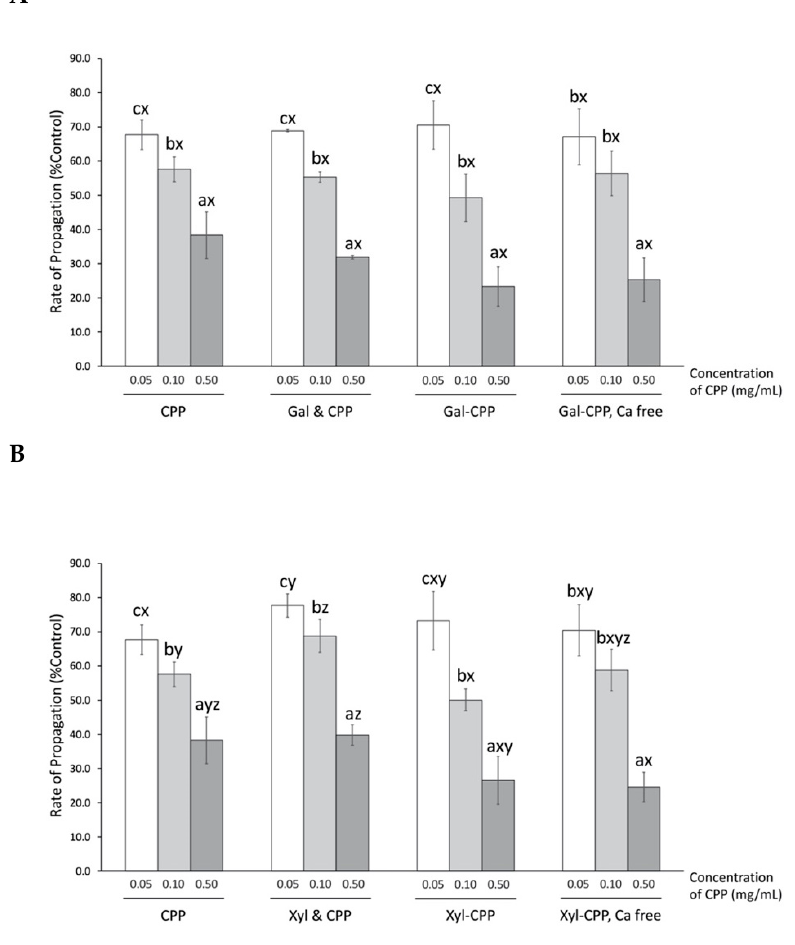
Figure 5. Rate of propagation of AAPH-induced soybean lecithin liposome peroxidation by CPP and CPP–polysaccharide (( A ) Gal; and ( B ) Xyl) conjugates and mixtures as percentage of that by control (percent control). Data from three individual experiments were submitted to linear regression, and the rate of propagation was calculated as the slope of regression equation. CPP, casein phosphopeptide; Gal (or Xyl) & CPP, non-conjugated mixtures of galactomannan (or xyloglucan) and CPP; Gal–CPP or Xyl–CPP, conjugates of galactomannan or xyloglucan with CPP formed by employing Maillard reaction conditions. All results are expressed as mean ± SD ( n = 3) and were statistically analyzed by one-way ANOVA and Tukey’s post-hoc test. Letters (a–c) denote significantly different means within the same treatment group, indicating effects of CPP concentration; letters (x–z) denote significantly different means within the same CPP concentration in an assay, indicating effects of treatment ( p < 0.01). 4. Discussion